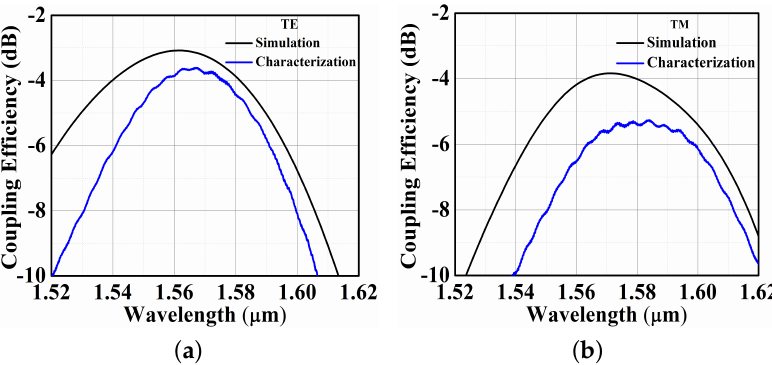
Figure 10. Simulated and characterization results for ( a ) TE gratings with 640 nm period. Experimental results are for 24 µ m focal length and ( b ) TM couplers with 980 nm period with optimum focal length of gratings used in experiments being 20 µ